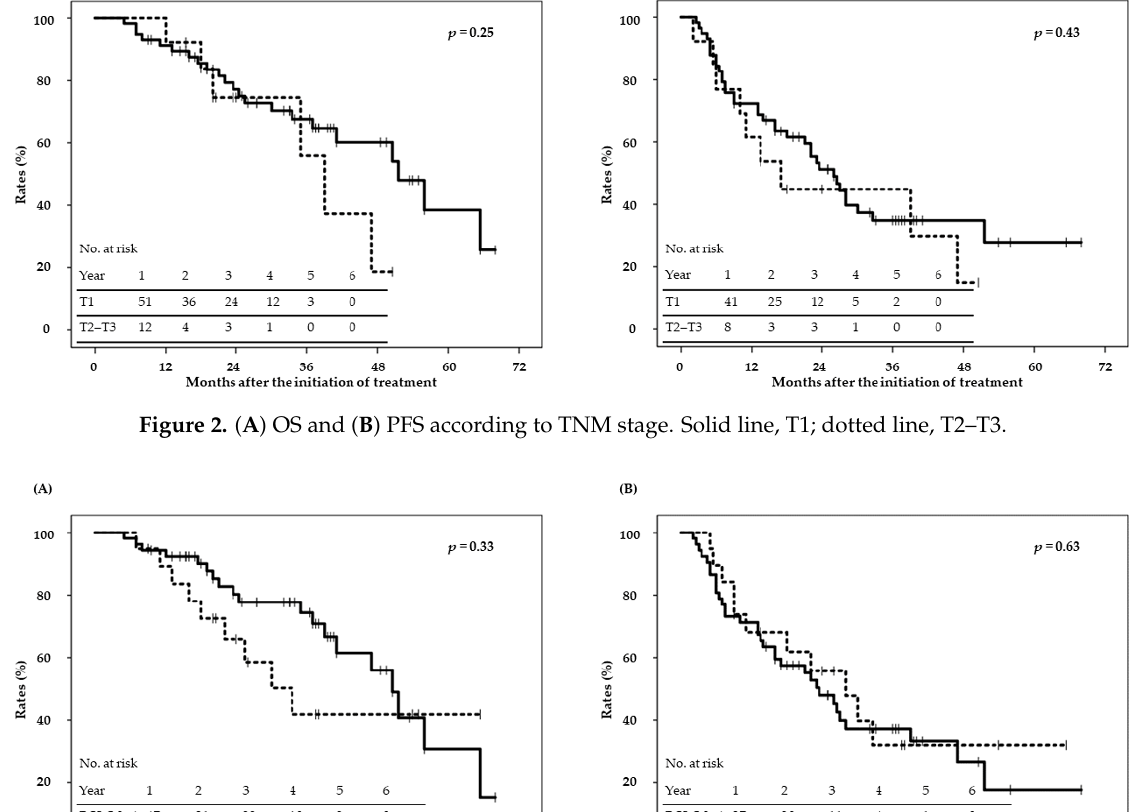
Cancers 2021 , 13 , x FOR PEER REVIEW Figure 1. Curves for overall survival (OS) (solid line), local control (LC) (dotted line), and progression- free survival (PFS) (dashed line) for all patients. Table 3. Uni- and multivariate Cox’s analyses for overall survival.